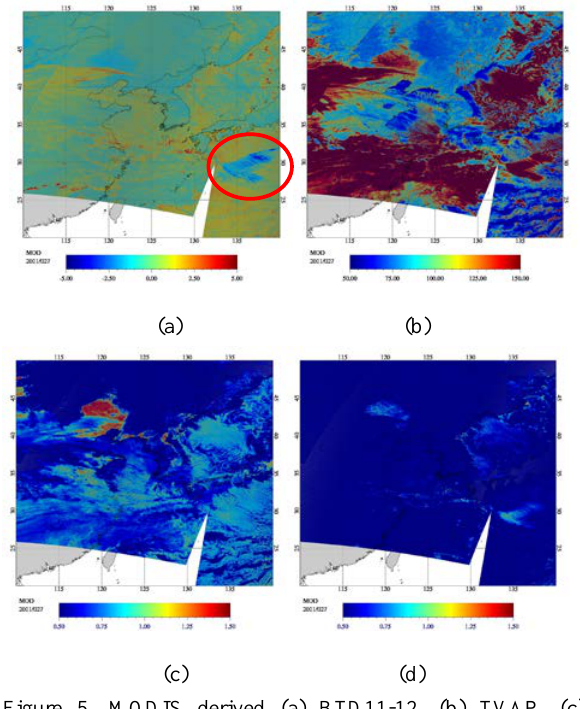
Figure 5. MODIS derived (a) BTD11-12, (b) TVAP, (c) ρ1.6/ρ0.8, and (d)